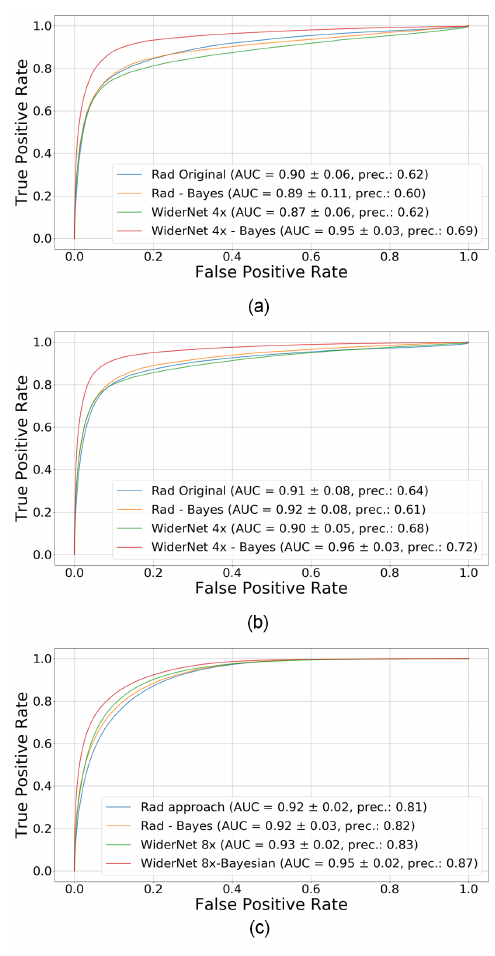
Figure 4. ROC curves for each dataset for Rad’s model and WiderNet 8 × , FCN 128 (i.e., with 128 neurons in their fully connected layer). ( a ) EDAQA dataset, study 1, ( b ) EDAQA dataset, study 2, ( c ) ESDB dataset. The Bayesian model with the higher capacity performs best in all datasets. Best viewed in